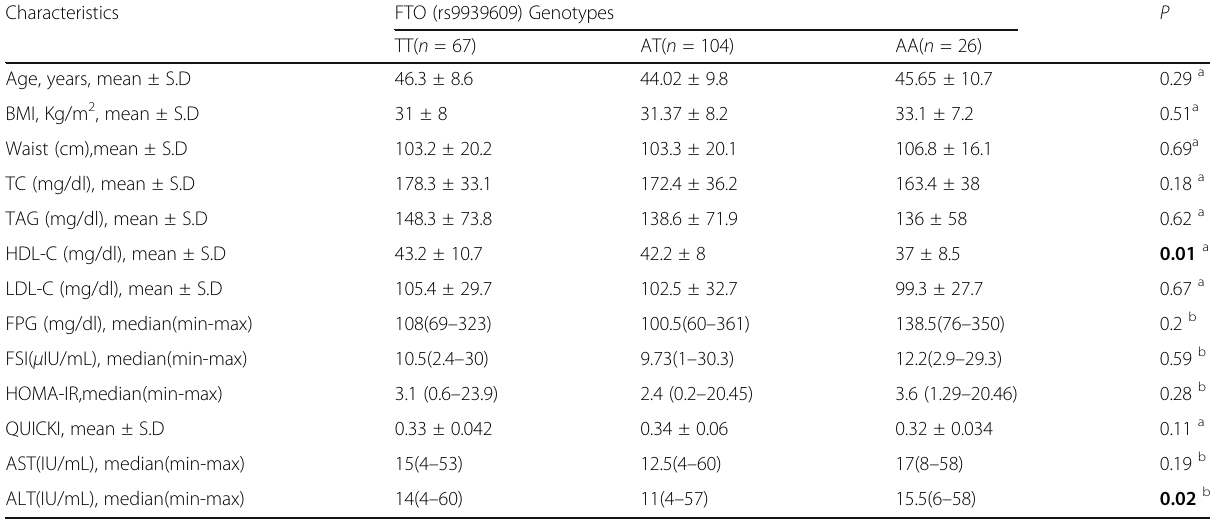
Table 3 association between FTO (rs9939609) polymorphism and Clinical characteristics of subjects